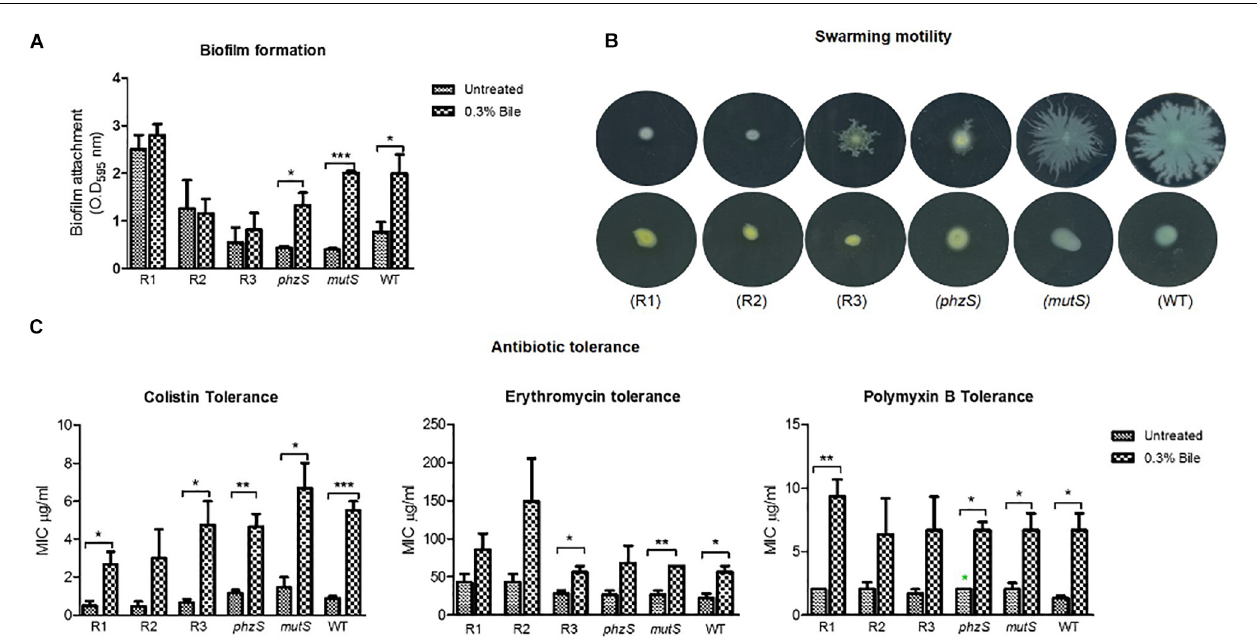
FIGURE 4 | Phenotypic profiling in the presence and absence of bile of the red pigmented derivatives, phzS and mutS transposon mutants and the PA14 WT strain for (A) biofilm formation. (B) Swarming motility. (C) Antibiotic tolerance. Data is the mean of at least three independent biological replicates. Statistical analysis was performed by Student’s t -test ( ∗ p ≤ 0.05; ∗∗ p ≤ 0.01; ∗∗∗ p ≤